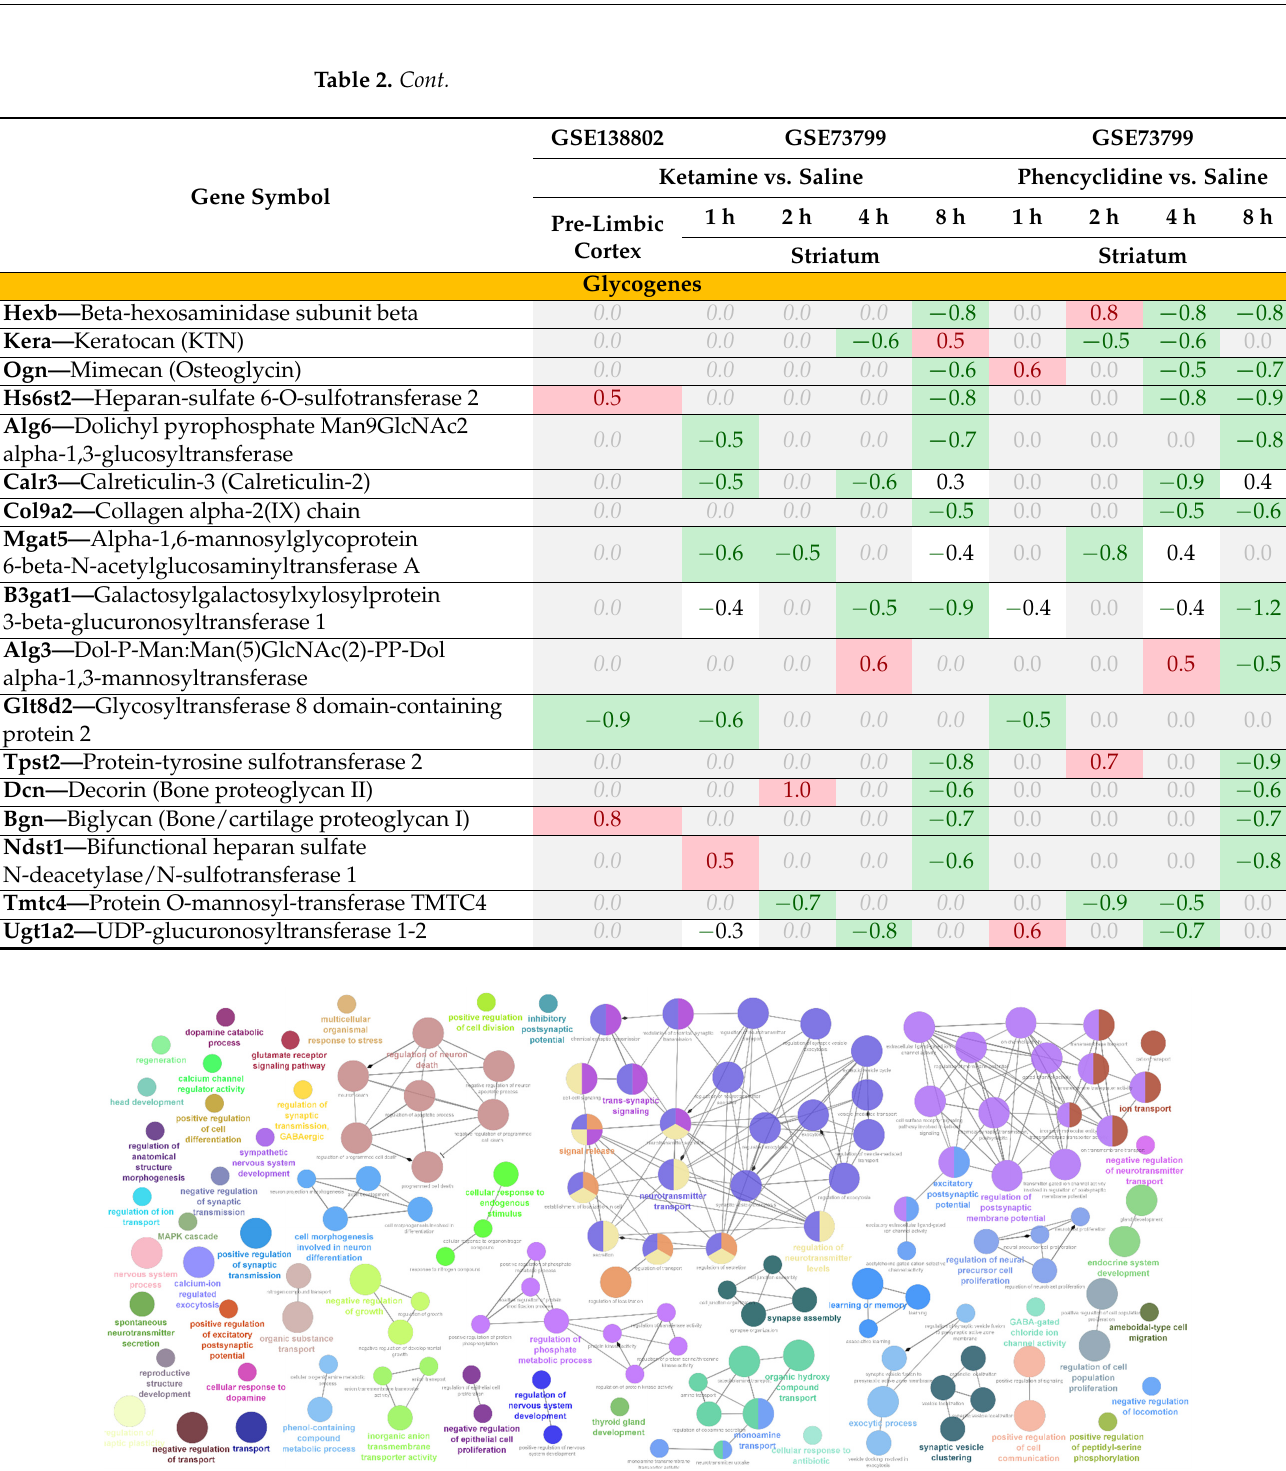
Figure 2. Gene ontology and pathway annotation network for the neuro-regulatory DEGs generated using the ClueGo v2.5.8 + CluePedia v.1.5.8 plugin via the Cytoscape software (v.3.9). The graph represents the enrichment analysis of the neuro-regulatory DEGs identified from the ketamine and phencyclidine treated rodent striatal tissue and the pre-limbic cortex. The GO-Biological Process-EBI-Unirpot-GOA-ACAP-ARAP-13.05.2021 was selected for the ontologies/Pathways and the evidence column was manually selected including the “All_Experimental”; RCA and TAS parameters. Pathways with p value ≤ 0.05 was selected for the filtering criteria and the CluePedia Option of five genes per term was selected for the visualization threshold. Network selectivity parameter was kept at Medium and the network connectivity Kappa score was set at 0.4.